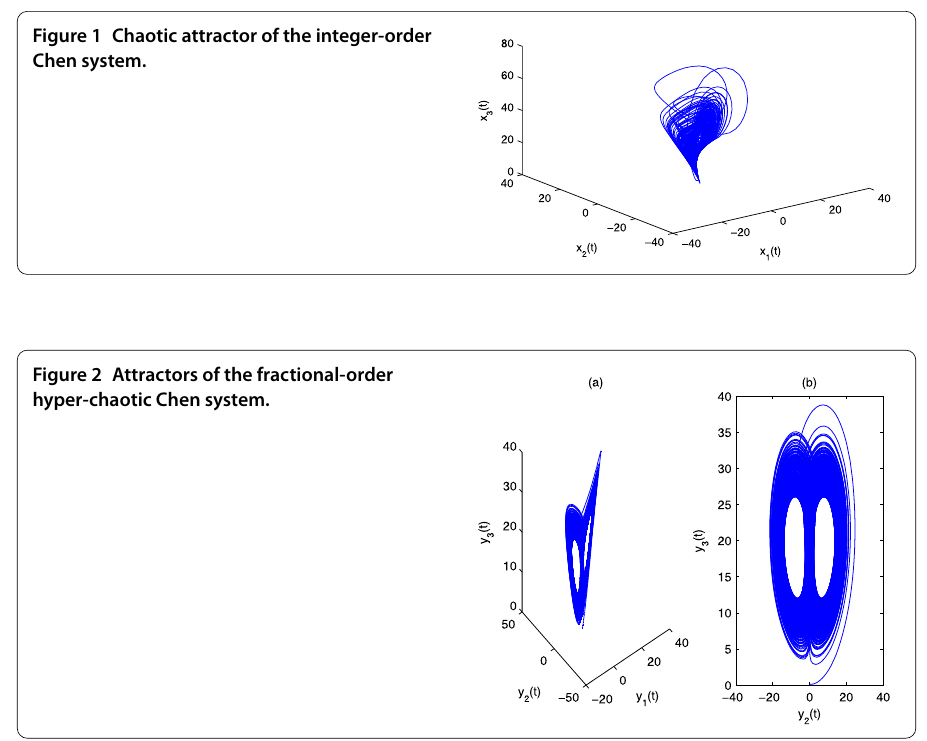
Figure 1 Chaotic attractor of the integer-order Chen system.